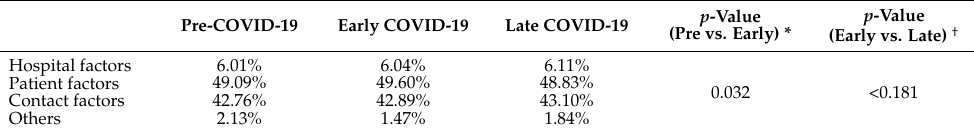
Table 5. Distribution of cancellation reasons by